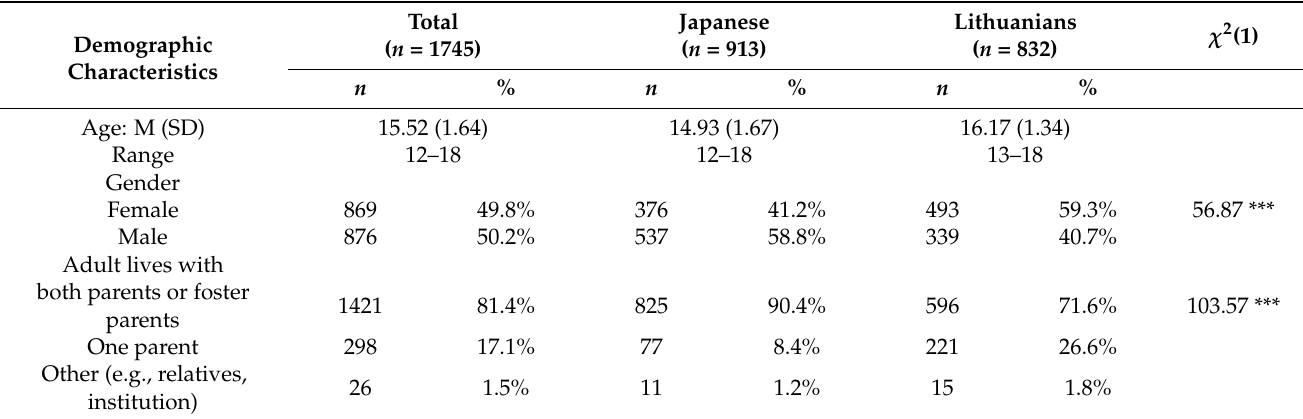
Table 1. Demographic characteristics of the participants ( n =